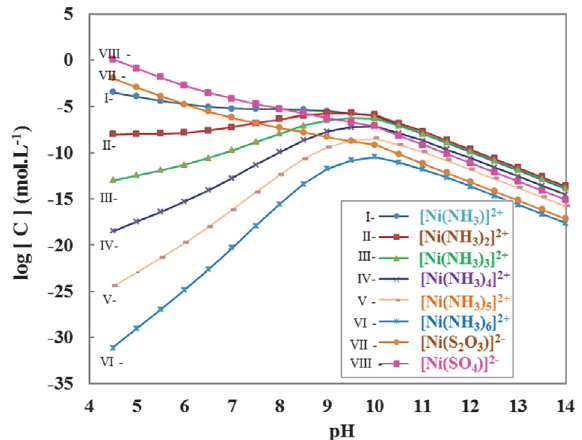
Figure 12 . Log concentration of nickel complex compounds, [NH 3 ] 0.01M, [CO 32– ] 0.1M, [SO 42– ] 0.02M, [S 2 O 32– ]